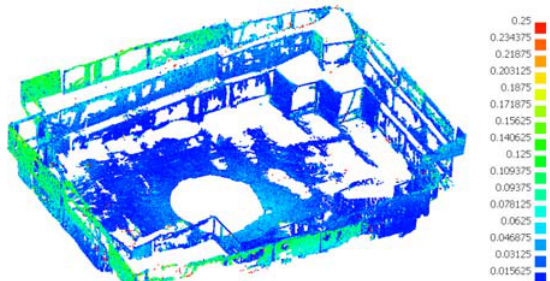
Figure 6. Error mapping of distances taking the TLS point cloud as ground truth.